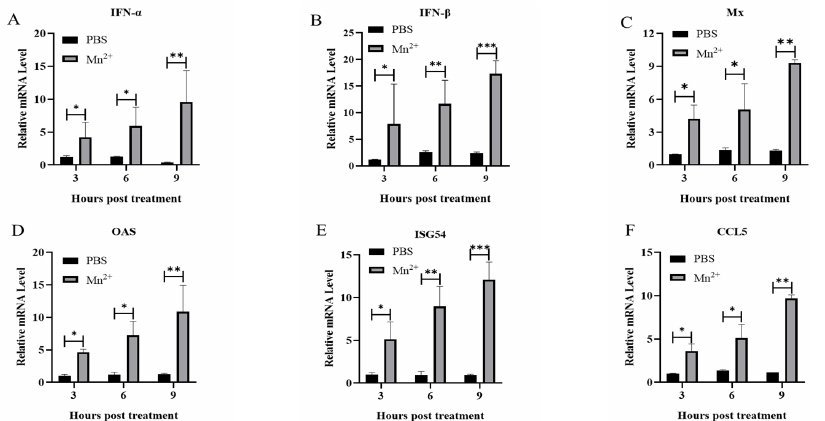
Figure 3. Activation of ISGs and IFN-I in PK15 cells treated with Mn 2+ . PK15 cells were treated with 50 μ M Mn 2+ and were collected at 3, 6, and 9 h following inoculation, and the mRNA levels of IFN- α ( A ), IFN- β ( B ), Mx ( C ), OAS ( D ), ISG54 ( E ) and CCL5 ( F ) were measured using RT-qPCR. A t -test was performed to identify statistically significant differences. *, p < 0.05; **, p < 0.01; ***, p < 0.001. 3.3. Enhanced Survival Rate of Mice Inoculated with Mn 2+ after Being Challenged by FMDV To investigate the in vivo antiviral activity of Mn 2+ , 5 weeks of mice ( n = 10) were intravenously injected with 1 mg/kg or 2 mg/kg Mn 2+ 12 h before mice were challenged with the virus with a lethal dose of of 2 × 10 5 TCID 50 and mice ( n = 10) inoculated with PBS as the untreated-control. The mice were daily monitored for 5 days. These virus-infected mice had significantly longer survival times after Mn 2+ pretreatment compared to the PBS control group. The results showed that 60% (6/10) and 80% (8/10) of mice pre-treated with Mn 2+ at 1 and 2 mg/kg respectively still survived at 84 hpi, but all PBS treated mice died at this time point (Figure 4A). A further analysis showed that viral RNA level significantly reduced in the heart (Figure 4B), spleen (Figure 4C), and pancreas (Figure 4D) collected at 48 hpi from the mice pretreated with Mn 2+ at 2 mg/kg. This demonstrated that Mn 2+ could enhance mice to resist FMDV infection.